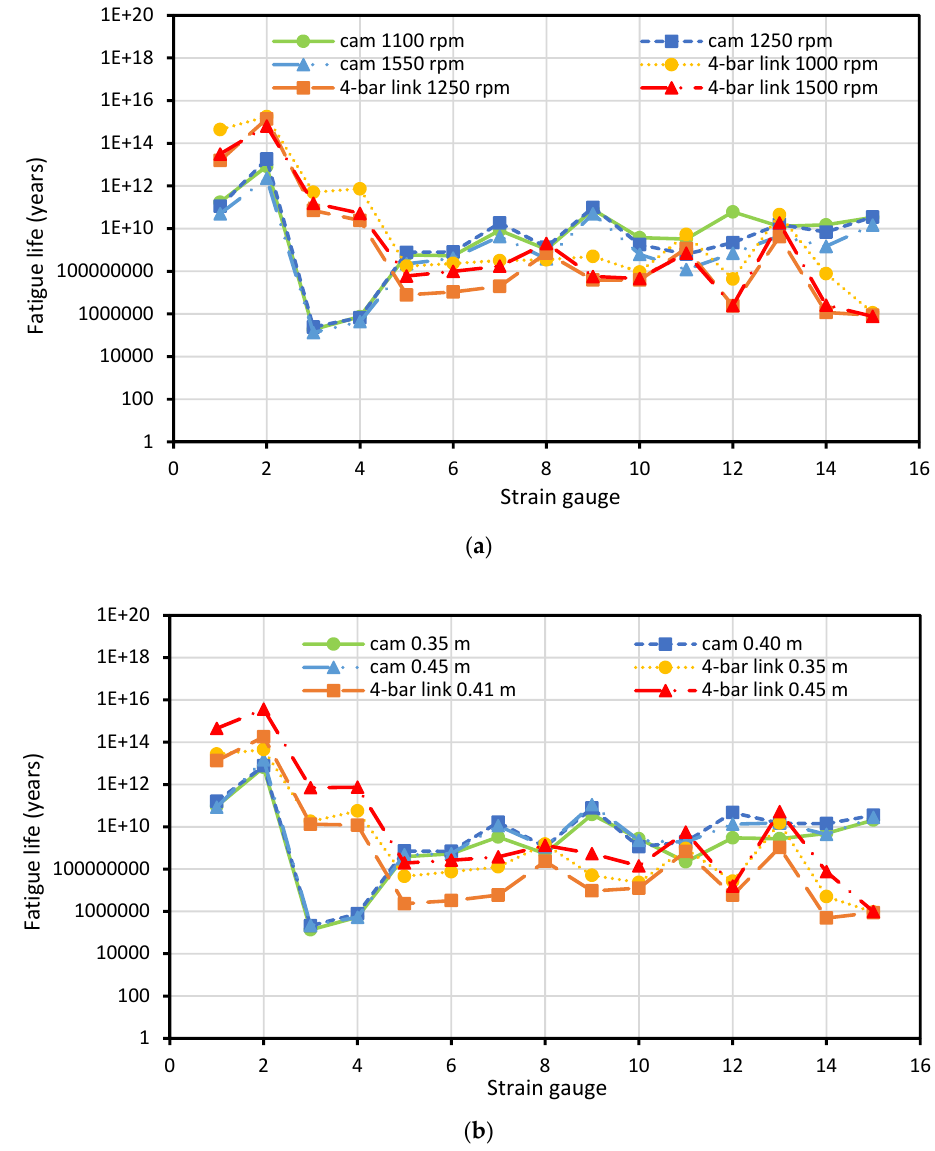
Figure 16. Comparison of fatigue life between cam and four-bar-link types on every strain gauge location on the transplanting device according to working conditions: ( a ) engine speed and ( b ) planting distance.